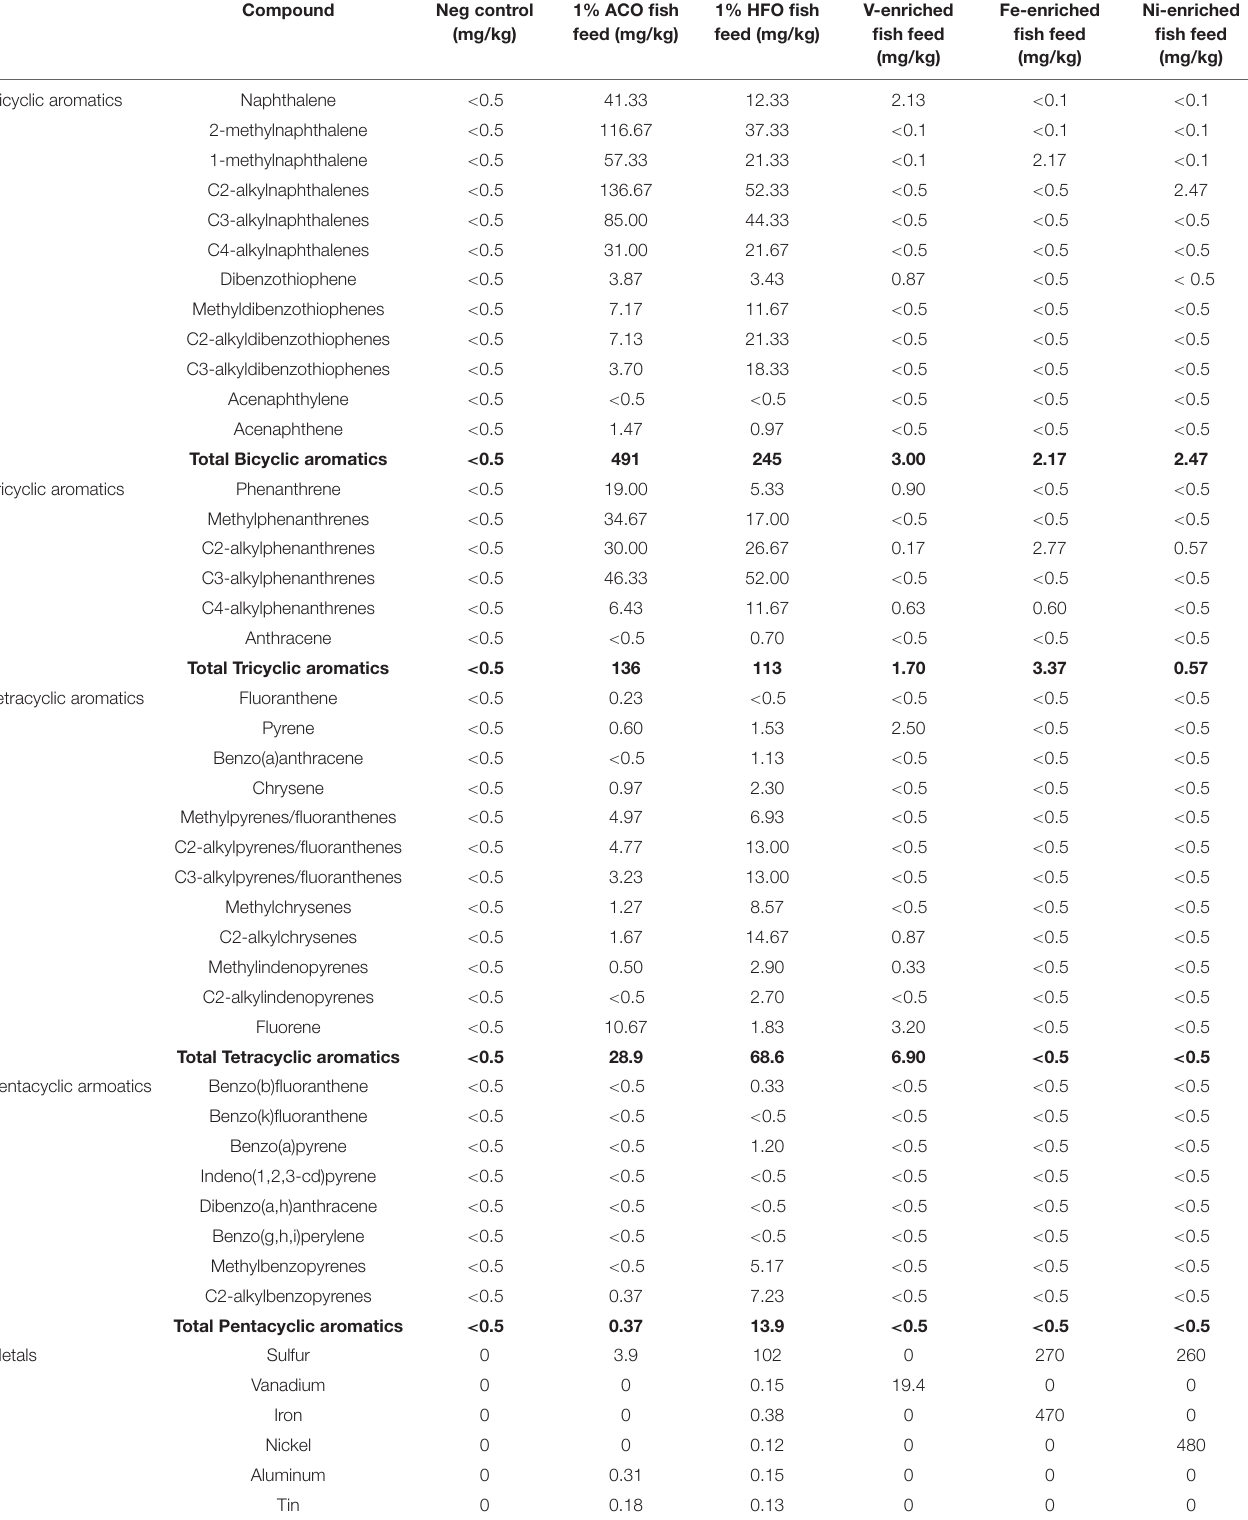
TABLE 1 | Toxicant additives in fish feed.